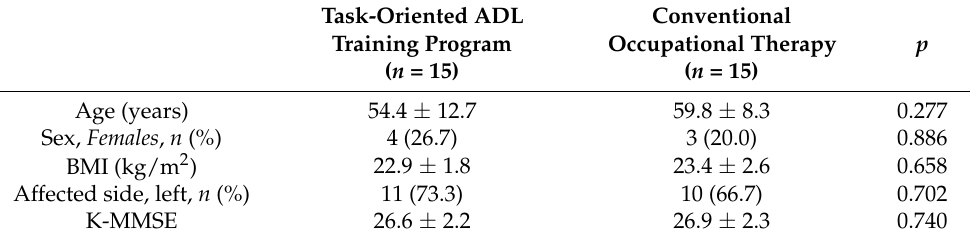
Table 2. General characteristics of the participants ( n = 30).